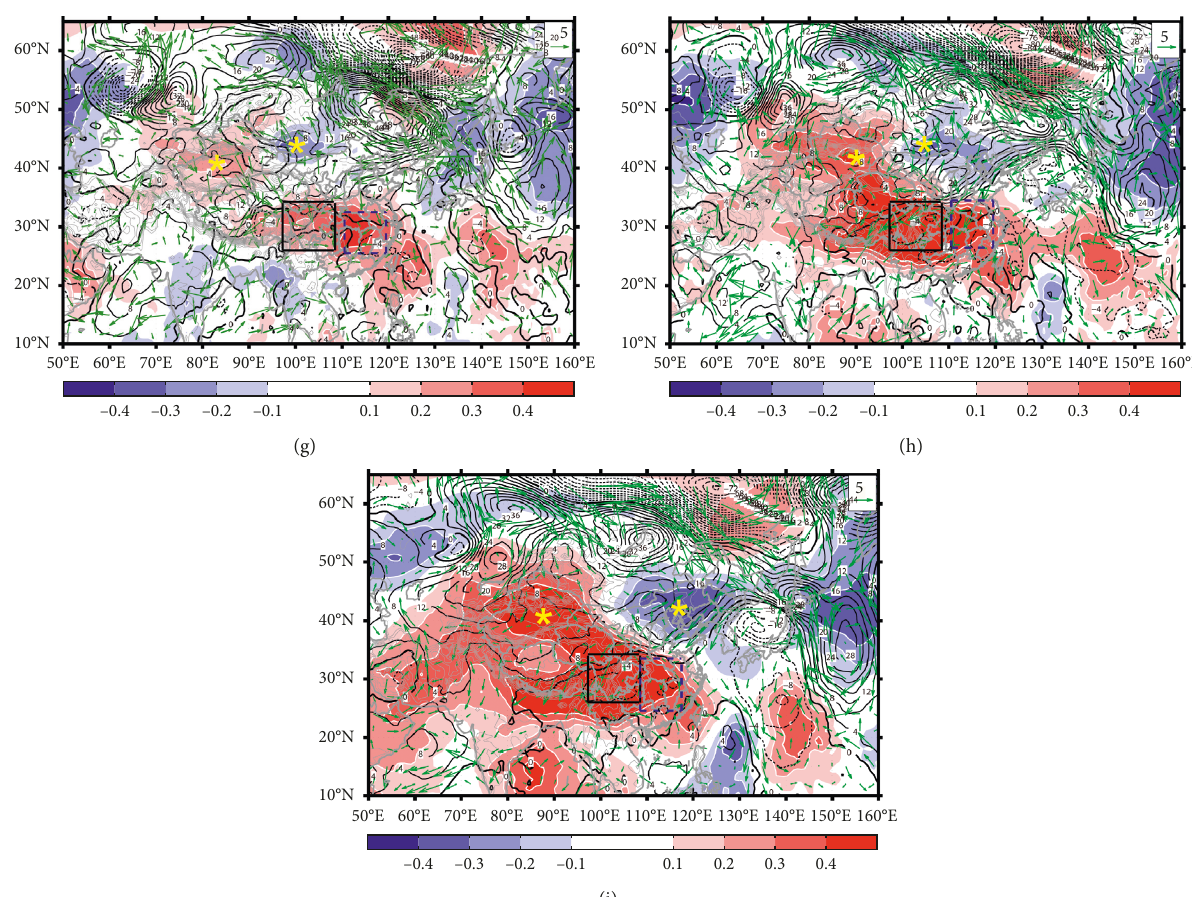
Figure 7: Correlation (color shading) between TPMVI and 500 hPa GPH in the 50-member forecast for next 0 to 84h (12h interval) is shown in (a–h) and for next 90–108 h (4-time average, 1800 UTC 17 July–1200 UTC 18 July) in (i) initialized at 0000 UTC 14 July 2013. The black contours and green vectors show the difference of 500 hPa GPH (contours; unit: gpm) and wind (vectors; unit: m/s) between six stronger and six weaker members (six stronger members minus six weaker members). The asterisk shows the significant location of the correlation according to the synoptic system’s coherent rules. The blue boxes in Figures 7(a)–7(i) show the area with correlation coefficient roughly beyond the 95% confidence level nearby WPSH, and the black boxes indicate the TPMV over the SCB,